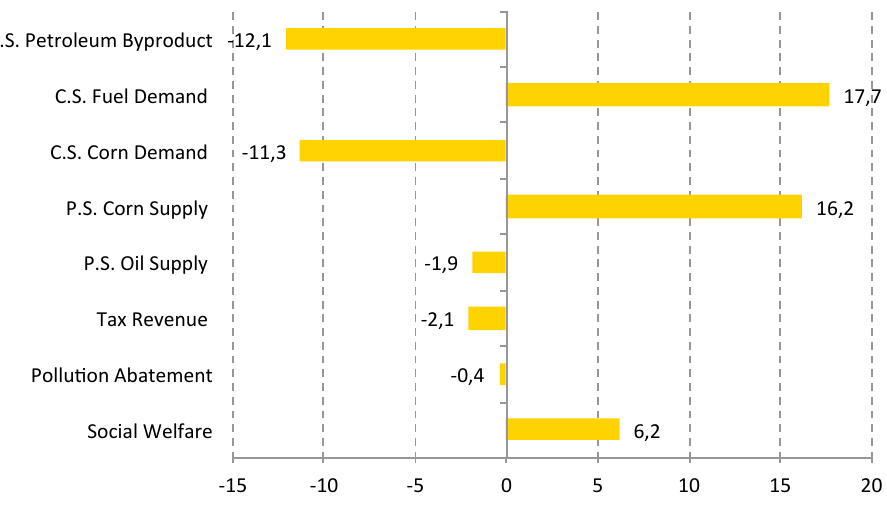
Figure 4. Welfare effects of the Status Quo ethanol policy (changes relative to “no ethanol policy”), $ billions (Source: Cui et al. , AJAE